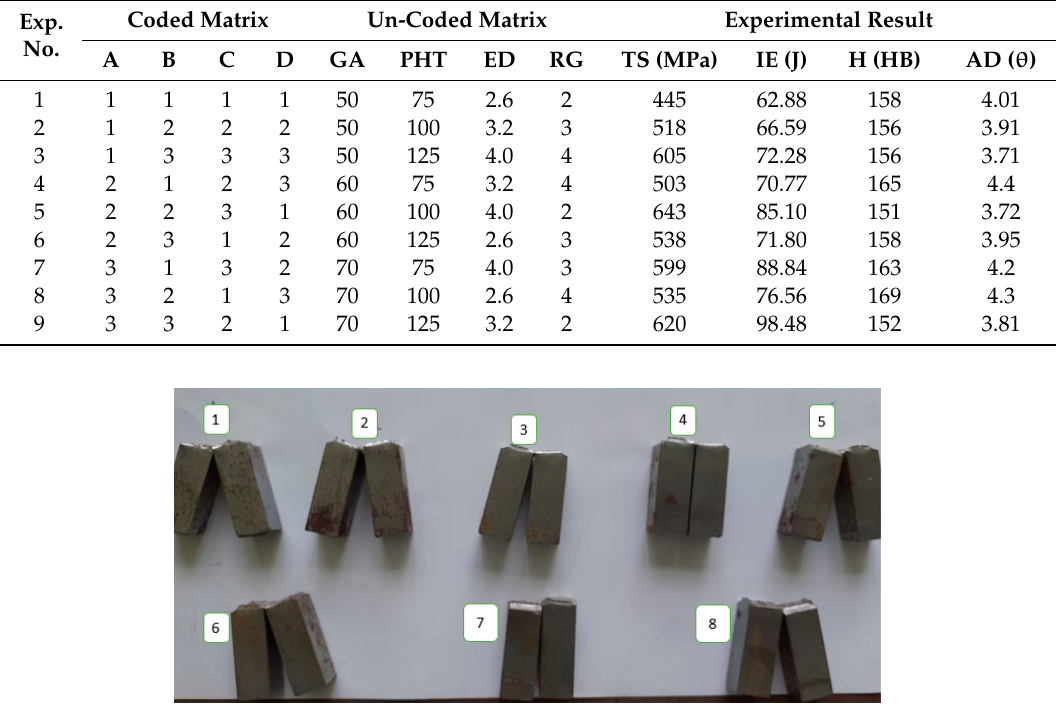
Table 2. Design Matrix and Experimental Results.